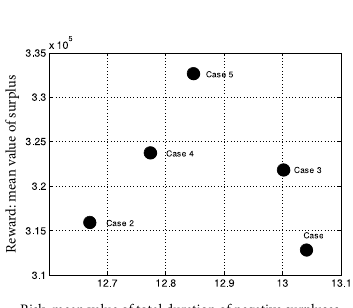
Risk: mean value of total duration of negative surpluses Fig. 11. The efficient frontier under Gaussian copula with catastrophe event